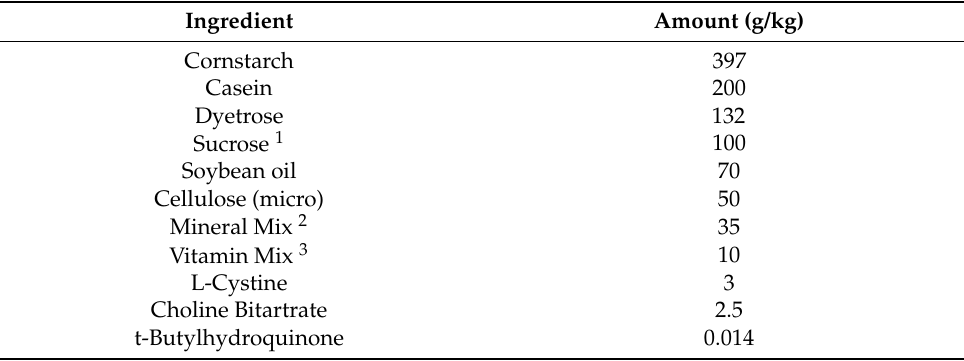
Table 1. Common ingredients in all 5 experimental diets. Ingredient